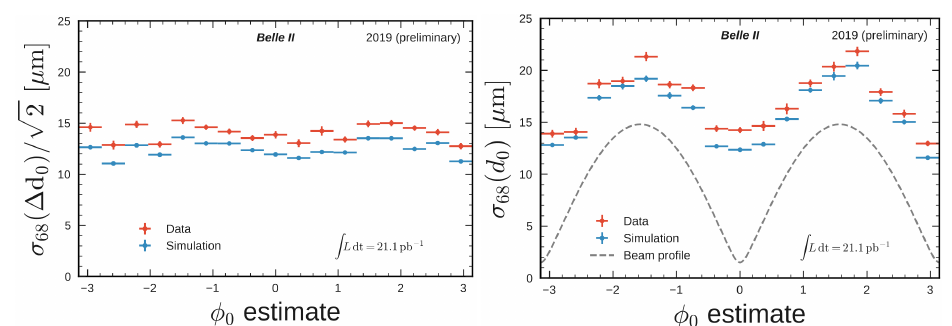
Figure 3: Transverse impact parameter resolution vs. φ 0 of a (positive) track, for di-muon and Bhabha events collected in early 2019 data, estimated with the standard method (left) and the method utilizing the very small luminous region size in the vertical direction (right). The beam profile (dashed line, which corresponds to σ i = 0 µ m) and simulation (blue) is using horizontal and vertical size σ x = 14 . 8 µ m and σ y = 1 . 5 µ m, respectively, calculated from machine parameters. Here σ 68 denotes half of the symmetric range about the median containing 68% of the